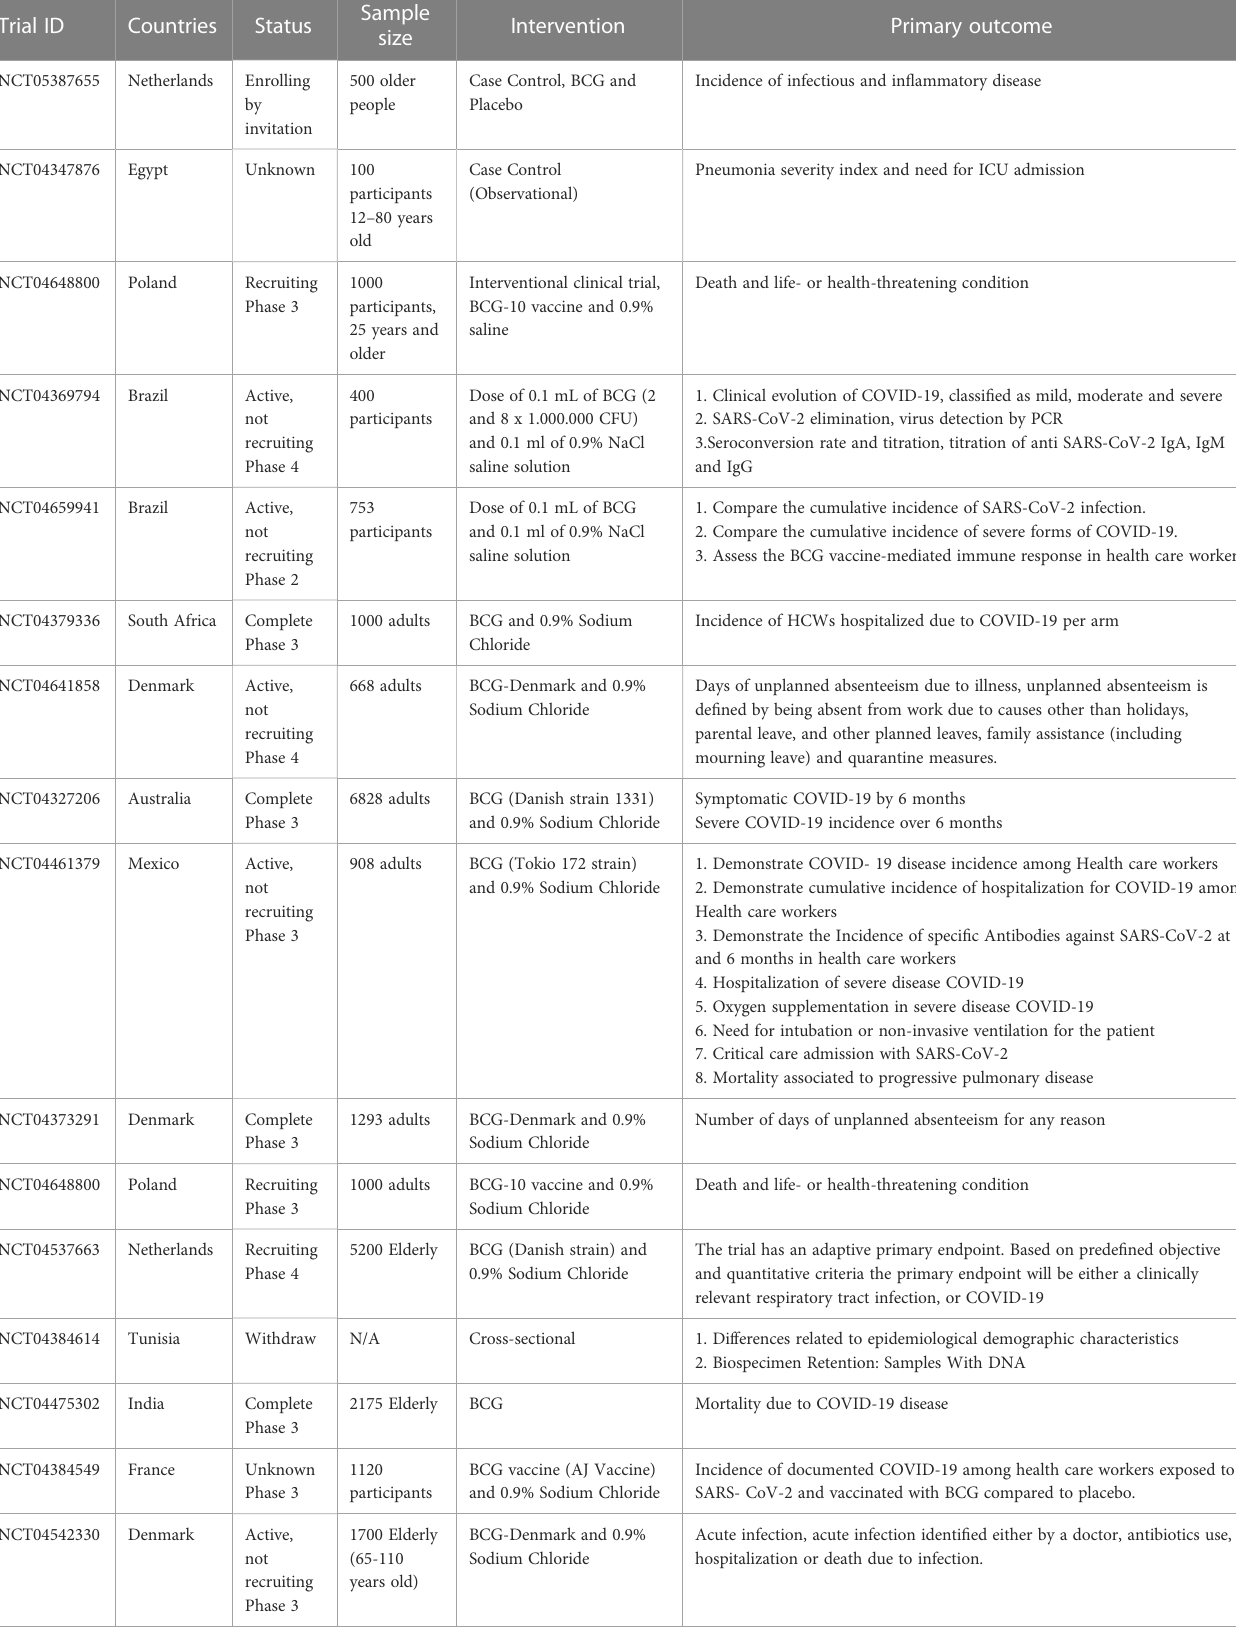
TABLE 3 Clinical Trials of BCG fi ghting against